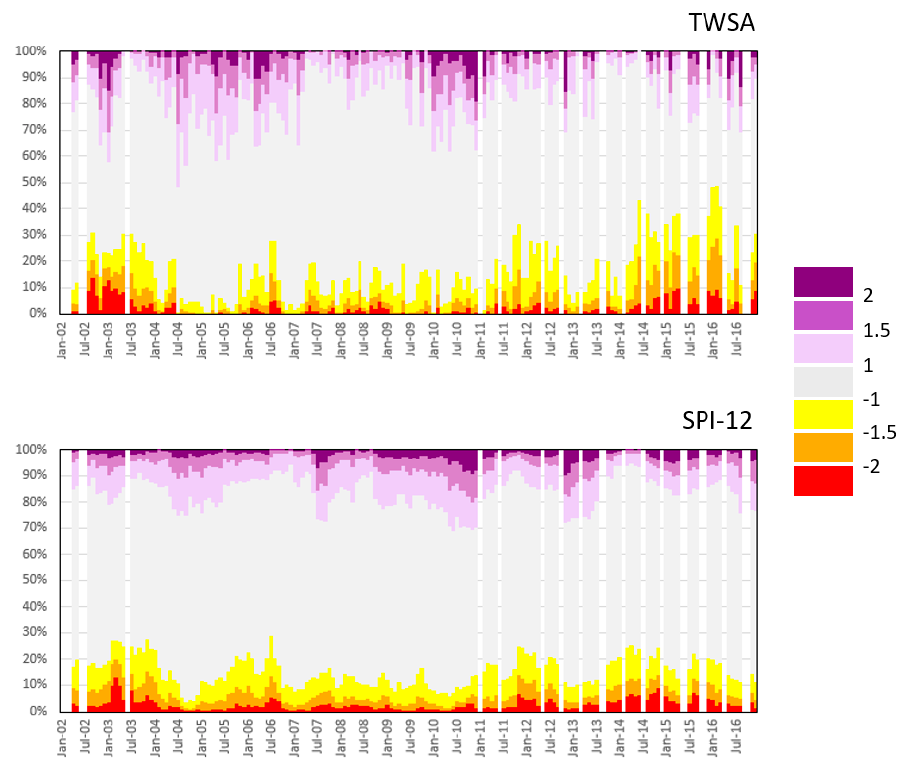
Figure 7. Time series of the fraction of cells over Europe within each of the seven sub-classes identified in [48] (see Section 2.3). The upper panel reports the data for TWSA, whereas the lower panel shows the results for SPI-12.